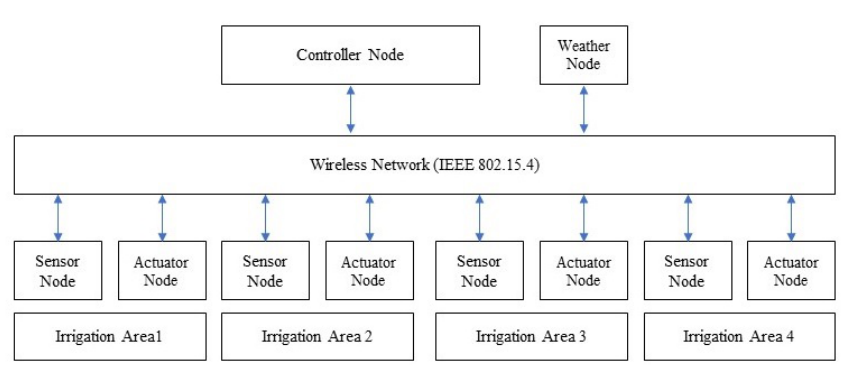
Figure 2. Networked control system for precision agriculture